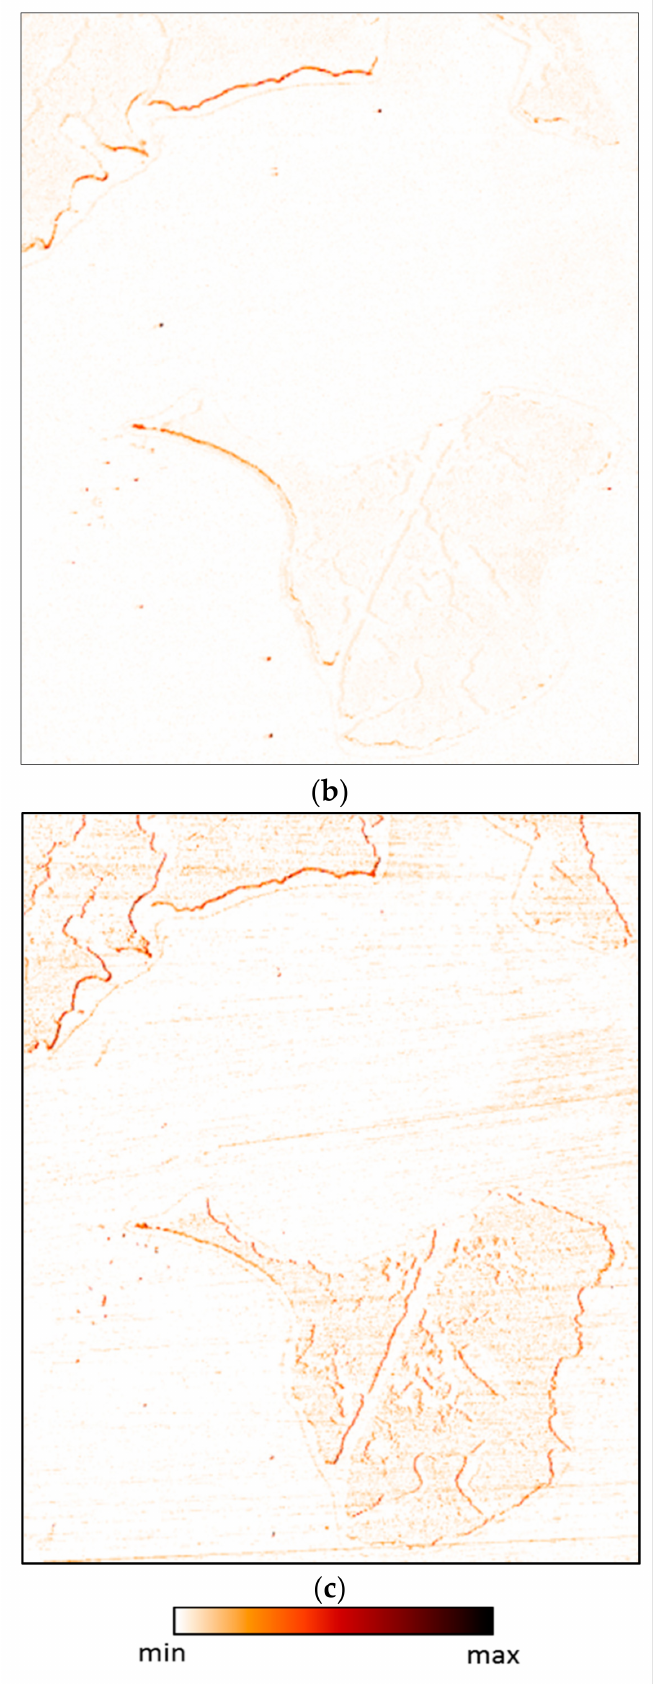
Figure 11. Area1700 ( a ), Aire2300 ( b ) and KHI ( c ). Histograms are adjusted on the entire images (linear stretch with min = 0, and max = 0.5 for Area1700 and Area2300, and max = 0.02 for